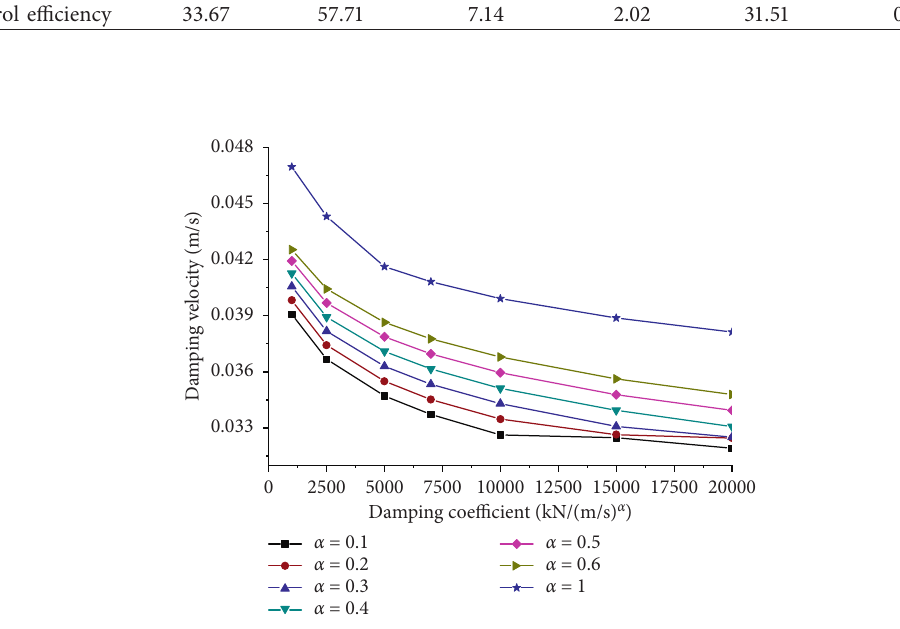
Figure 23: Maximum value of damping velocity V